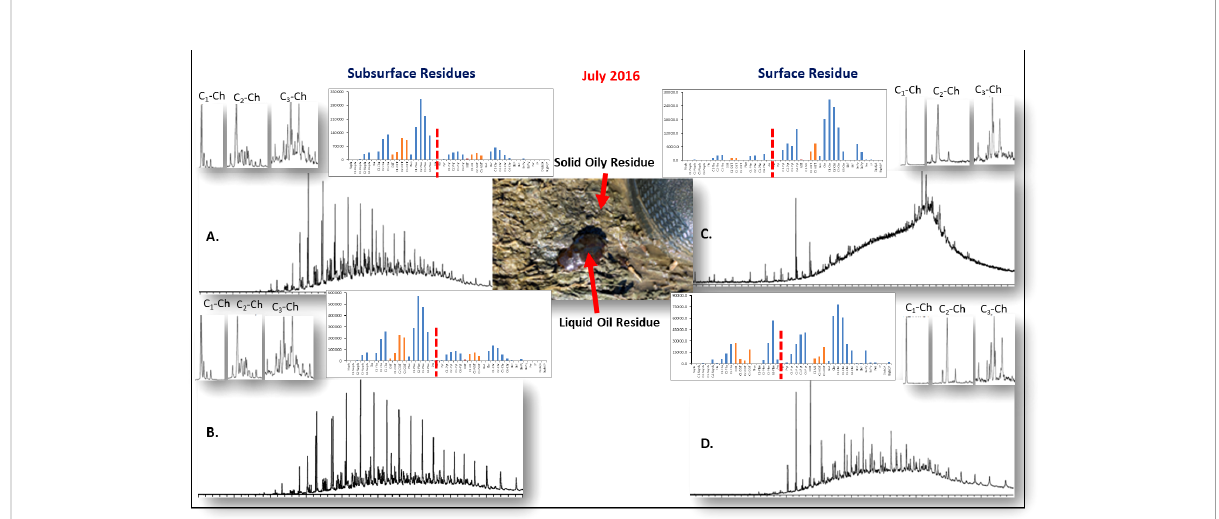
FIGURE 13 Outline of the compositional pro fi les of four oil residues stranded in coastal marshes in Bay Jimmy area of Barataria Bay Louisiana. The surface soil/sediment core samples impacted by the stranded DwH oil were collected in July 2016. Surface oil residues on sediments (A) and vegetated tarmat (B) were heavily weathered aerobically. Small amounts of stranded oil were trapped in abandoned fi ddler crab burrows and under heavily weathered vegetated oil residues mats laying on the marsh shoreline when stranded in 2010. These latter stranded oil samples (C, D) underwent very slow anaerobic degradation over time when compared to surface oil residues in aerobic sands and